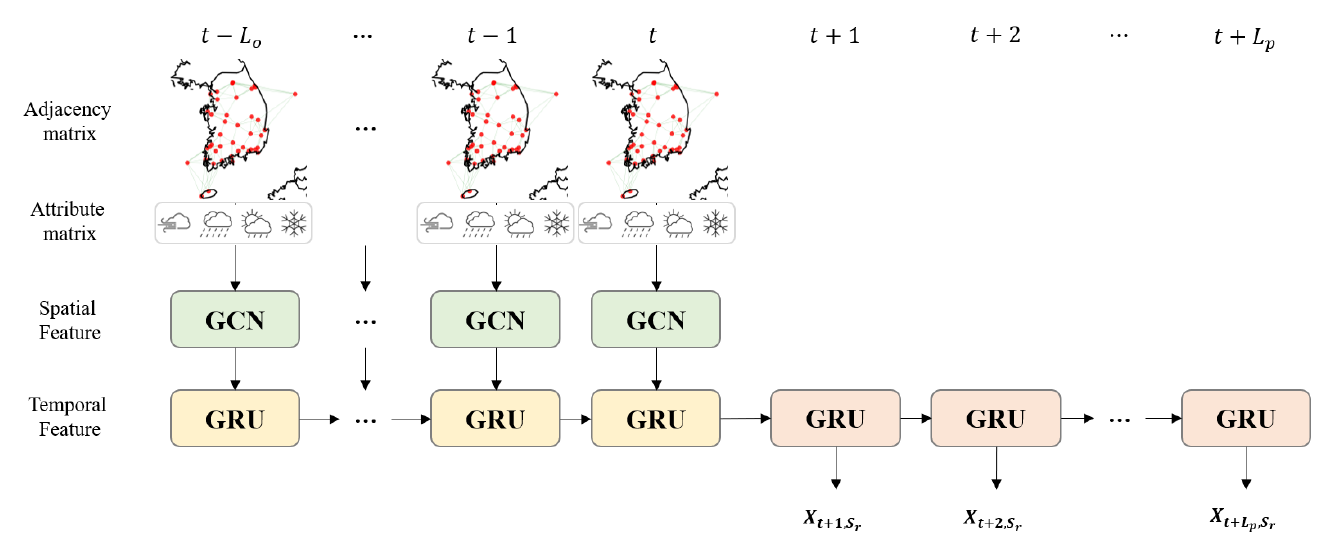
Figure 2. An overview of the proposed model. Spectral graph convolution layers extract structural features of meteorological networks and spatial correlations of meteorological variables with adjacent ASOS stations at each time point. GRU layers learn temporal correlations of solar irradiance with other meteorological variables by analyzing feature vectors that come from the graph convolution